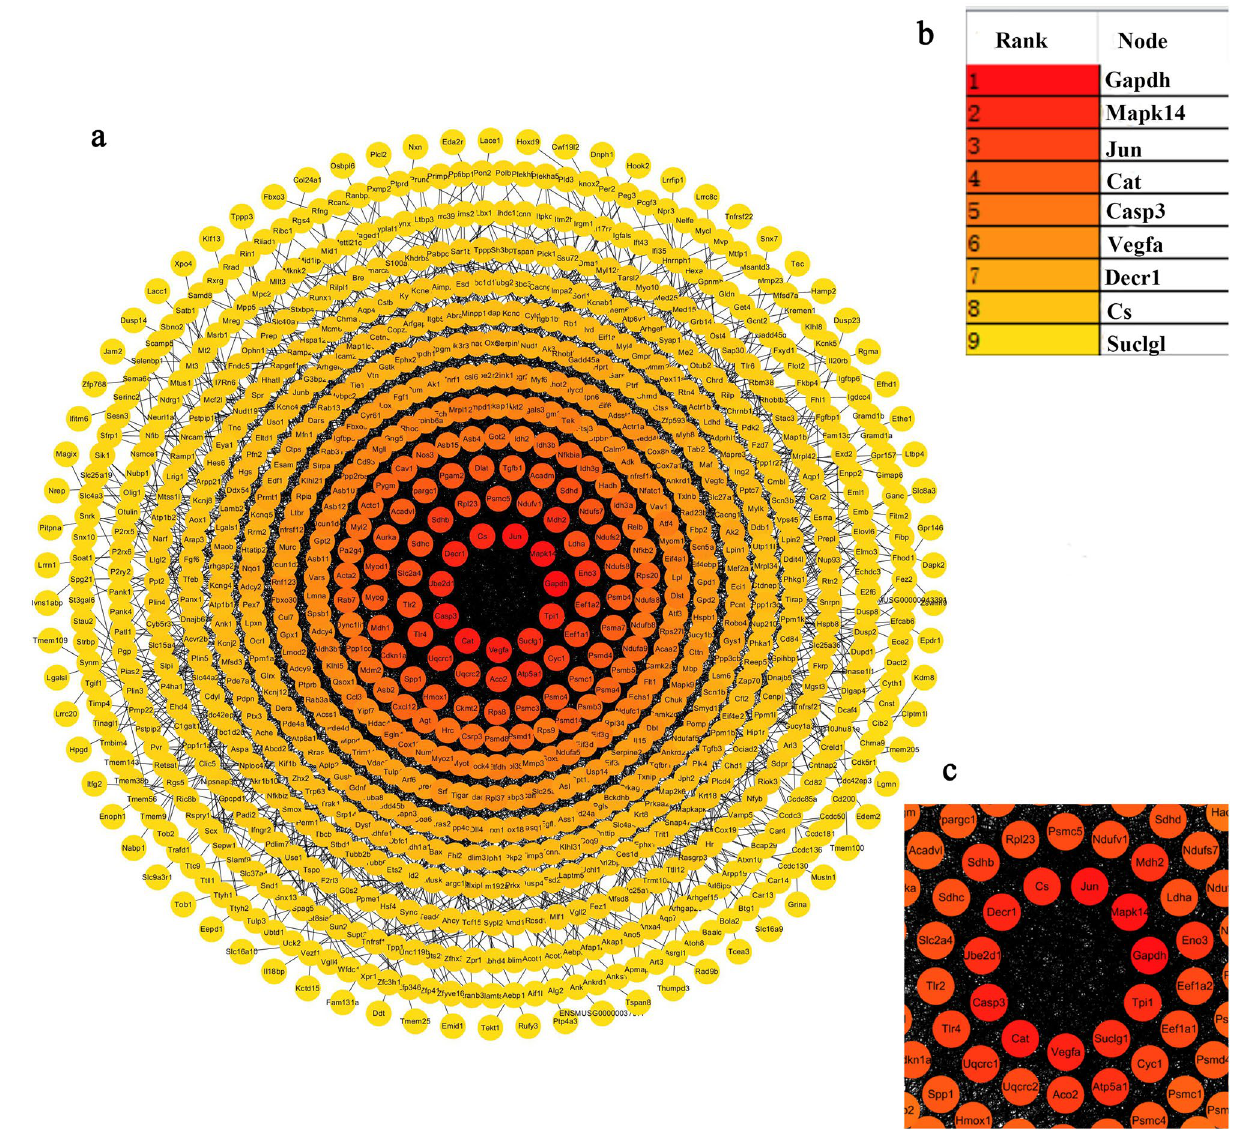
Figure 3. PPI network in denervated muscle atrophy. ( a ) PPI network, the color was used to reflect the level of degree, the higher the degree, the darker the node color. ( b ) The top10 DEGs with the highest degree. ( c ) Partial enlarged view of PPI network. STRING v11.0 was used to generate protein interactions, and the resulting network was visualized using Cytoscape